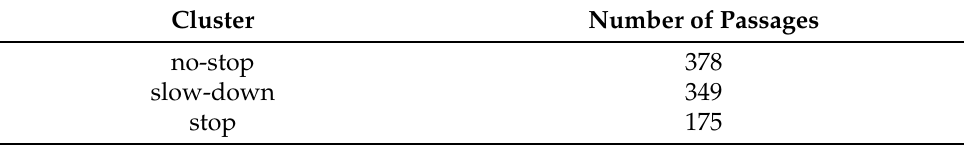
Number of passages classified in each of the three clusters after analyzing the | ˜ P | = 4096 straight passages. It can be noted that the sum of the passages over the three clusters does not add to 4096 because not all the passages belong to a cluster.